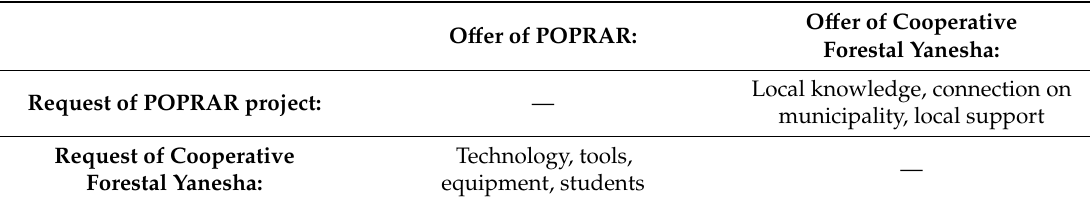
O ff ers and request of POPRAR (Support of Practical Competencies in Regional Development)